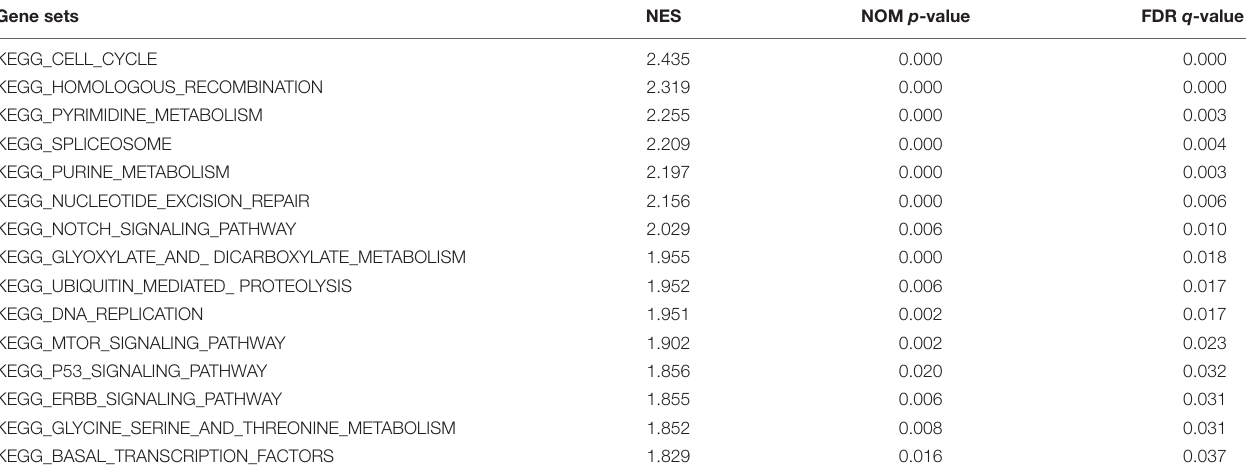
TABLE 9 | Signaling pathways enriched in the QSOX2 high